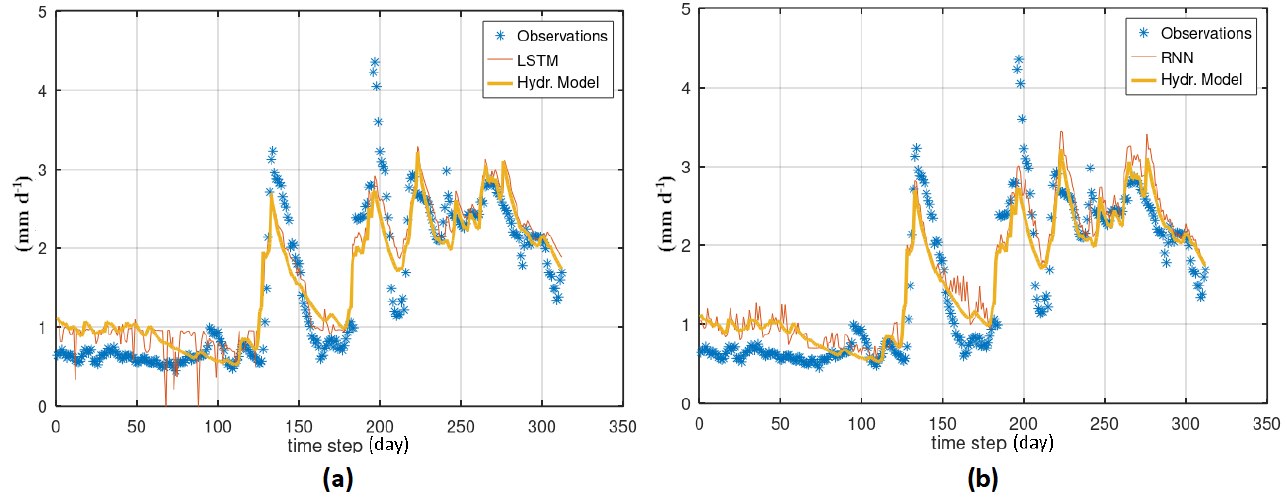
Figure 12. Assessment of the HYMOD2 model in the Nyangores River. LSTM ( a ) and RNN ( b ) employed to approximate the best model that can be obtained with the available data during the HYMOD2 test